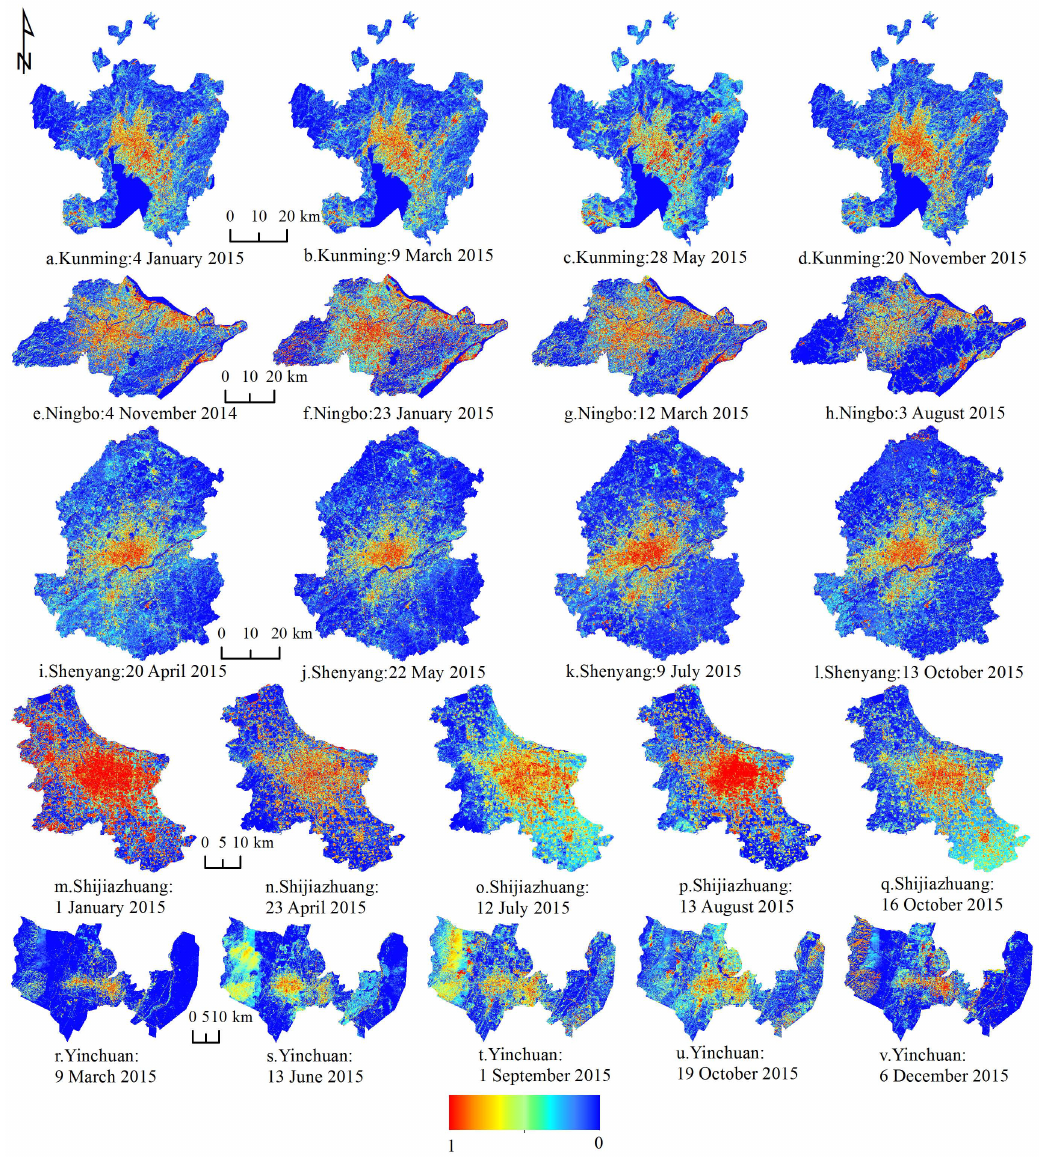
Figure 5. Impervious surface area in five cites based on images taken during different seasons. From blue to red, the percentage of impervious surfaces gradually